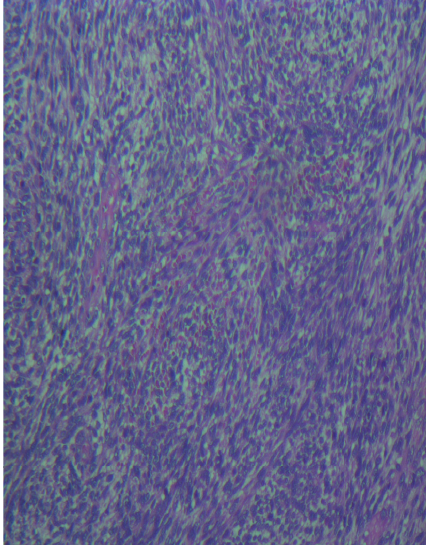
Figure 4: Photograph of pneumoblastoma type II showing malignant mesenchymal cell